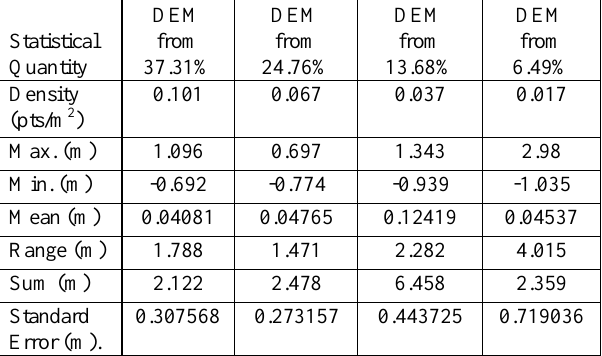
Table 2a: Statistical analysis of the residuals of the elevations extracted from DEMs created from LiDAR data of different point cloud densities at the positions of checkout points.